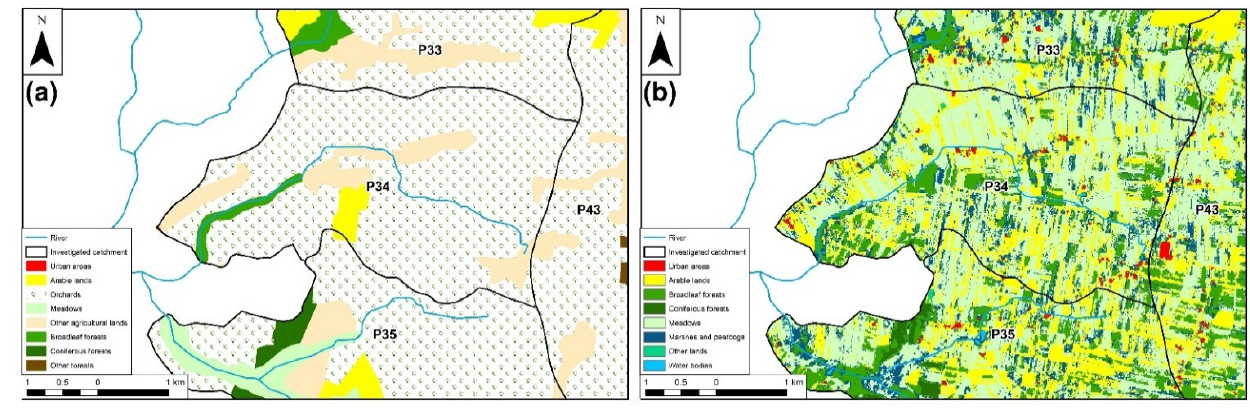
Figure 4. A spatial comparison of CLC 2018 ( a ) and S2GLC ( b ) datasets regarding the P34 catch-